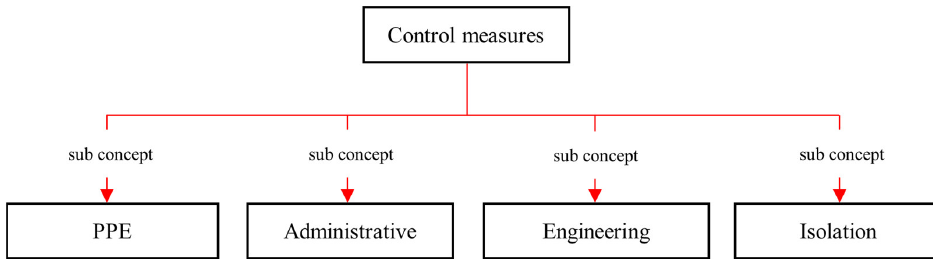
Figure 7. The sub-concepts of control measures.